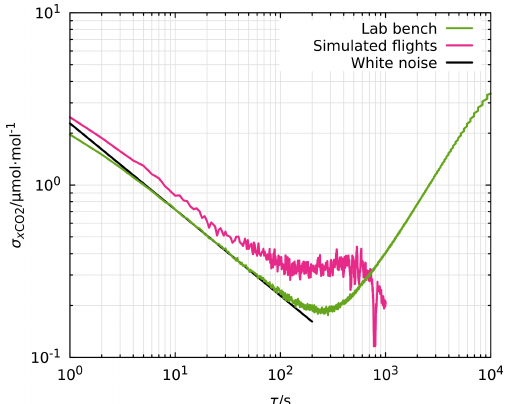
Figure 8. Stability test in an environmental chamber. The variations in ambient pressure p and temperature T approximately represent three flights between 0 and 1000m above sea level in the Interna- tional Standard Atmosphere. Air with constant dry air mole fraction of CO 2 was supplied to COCAP from a cylinder. Calibrations were carried out before and after the flights (not shown) using two gas standards (397.5 and 447.4µmolmol − 1 ). The dry air mole fraction x CO measured with COCAP has been smoothed by convolution 2 with a Gauss window of 200s full width at half maximum in order to reduce the high-frequency noise. The sharp features in pressure were caused by turning the environmental chamber’s pressure reg- ulation off after and back on before each